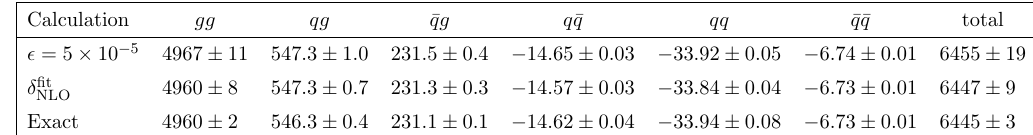
Table 2 . Comparison between NLO coe(cid:14)cients computed by MCFM, both exactly (using dipole subtraction) and by jettiness slicing (boosted de(cid:12)nition of T 1 ). Results are shown for (cid:15) = 5 (cid:2) 10 (cid:0) 5 in the de(cid:12)nition of (cid:28) cut and for a combination of (cid:12)t values ( gg , qg , (cid:22) qg ) and results for (cid:15) = 2 : 5 (cid:2) 10 (cid:0) 5 ( q (cid:22) q , qq , (cid:22) q (cid:22) q ), denoted by (cid:14) (cid:12)t . Note that the total column includes a factor of two for channels that NLO are not